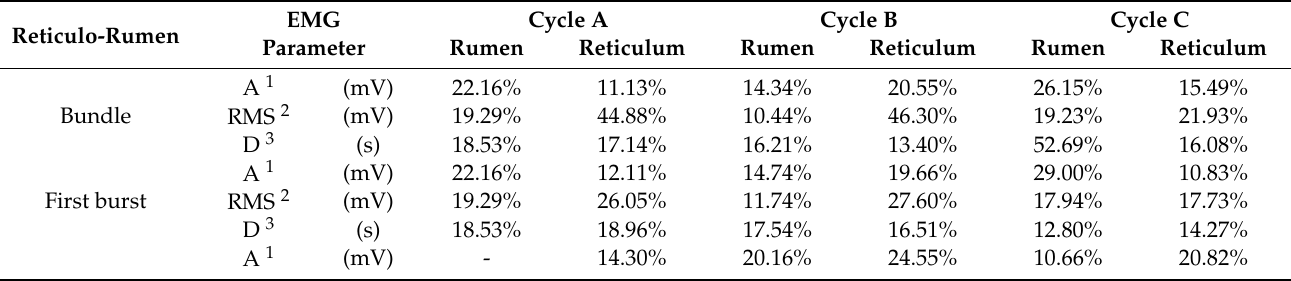
Table 2. The coefficient of variation (CV, %) for EMG signal parameters in the reticulo-rumen during cycles A, B, and C calculated across animals ( n =